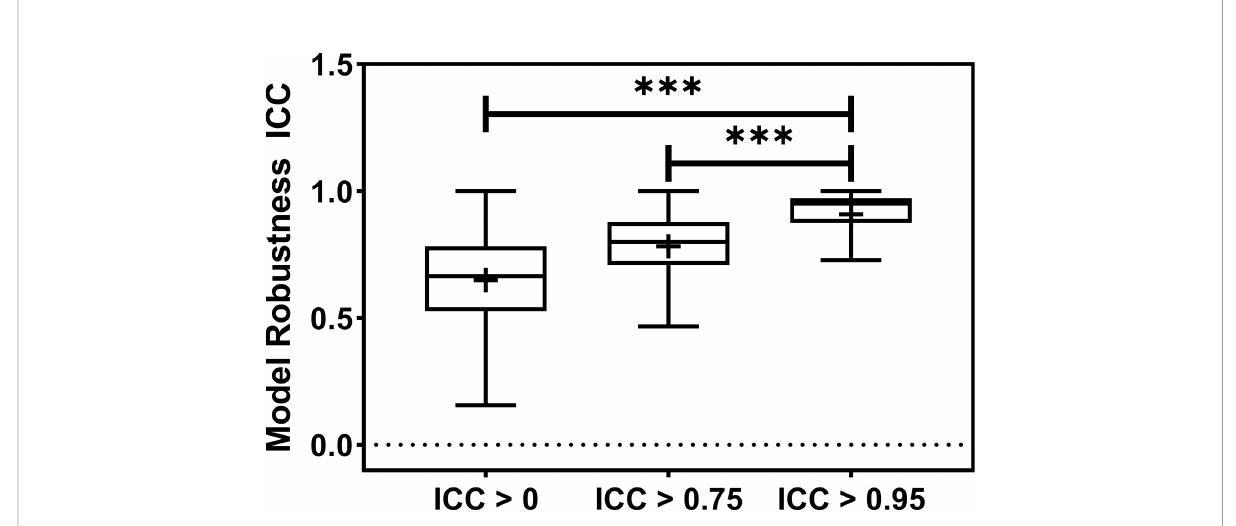
FIGURE 3 The barplot shows the model robustness ICC distribution for three feature robustness fi ltering groups, ICC > 0, ICC > 0.75, and ICC > 0.95. The feature robustness fi ltering of ICC > 0.95 yields the most robust model. *** indicates the p-value is smaller than